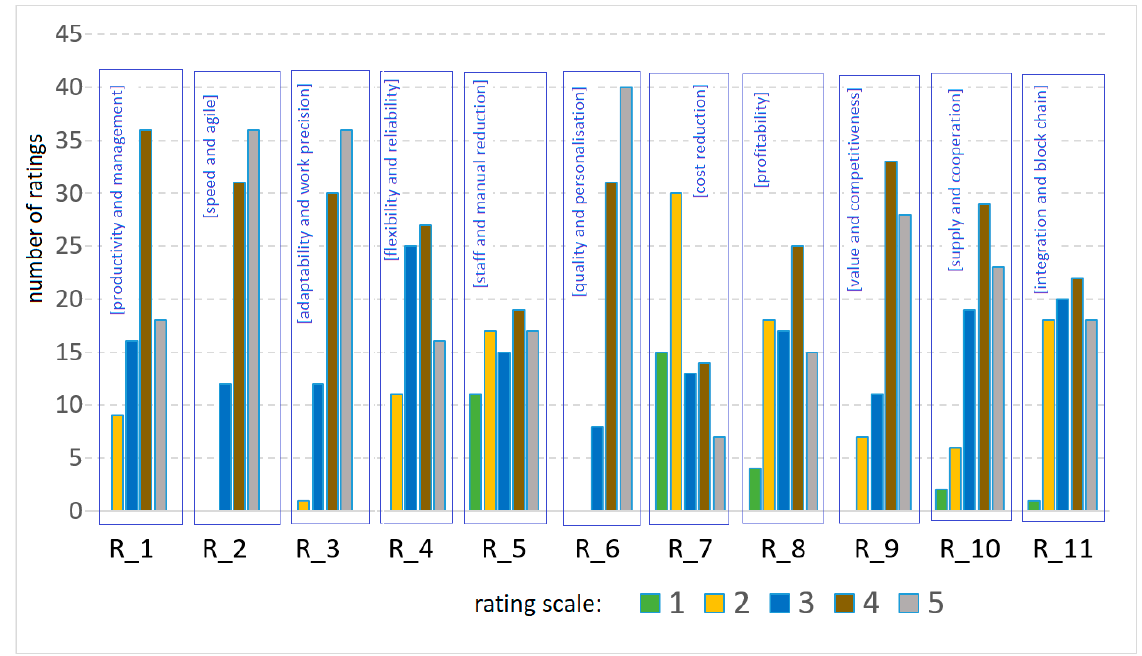
Figure 3. Distribution of ratings according to different categories of influence of SM projects on enterprise operations. Source: own research [73]. Table 3. Influence of the SM projects on business operation according to categories with the high- est